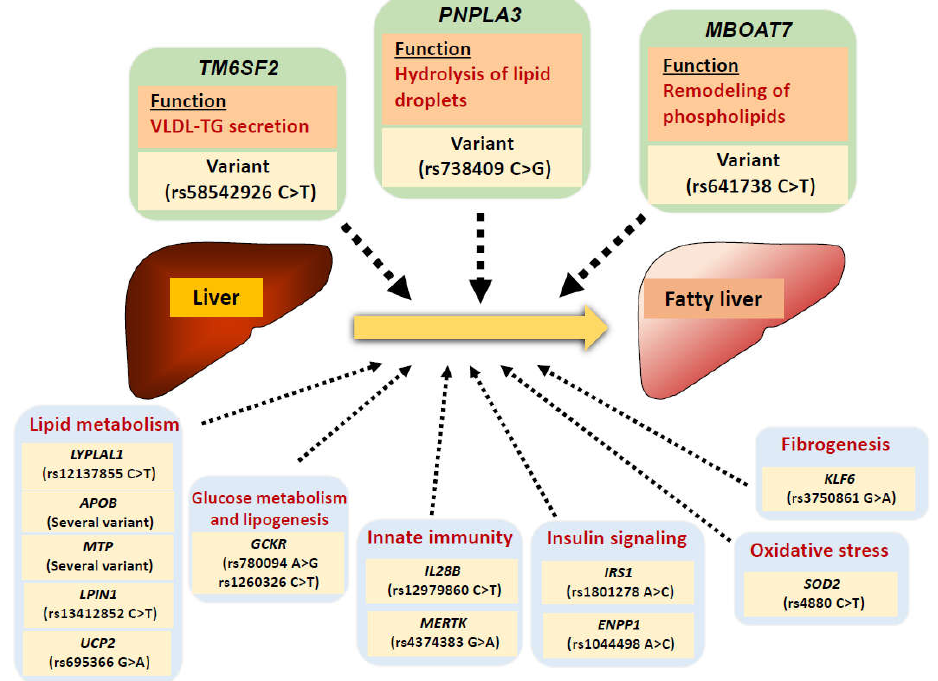
Figure 1. Summary of genetic variants related to the pathogenesis of NAFLD. Many genome-wide association studies have identified novel loci associated with disease severity phenotypes of NAFLD. The PNPLA3 (rs738409 C>G) variant, which causes impaired mobilization of TG from lipid droplets, predisposes to progression along the full spectrum of liver damage associated with fatty liver. The TM6SF2 (rs58542926 C>T) variant, a loss-of-function variant, is associated with hepatic steatosis via decreased VLDL-TG secretion in the liver. The MBOAT7 (rs641738 C>T) variant, resulting in lower MBOAT7 protein expression in the liver, is associated with increased hepatic fat content through inducing changes in the remodeling of phospholipids. In addition, other genetic variants known to be involved in the regulation of lipid metabolism ( LYPLAL1 , APOB , MTP , LPIN1 , UCP2 ), glucose metabolism and lipogenesis ( GCKR ), innate immunity ( IL28B , MERTK ), insulin signaling ( ENPP1 , IRS1 ), oxidative stress ( SOD2 ), and fibrogenesis ( KLF6 ) have also been reported to be associated with the progression of NAFLD.